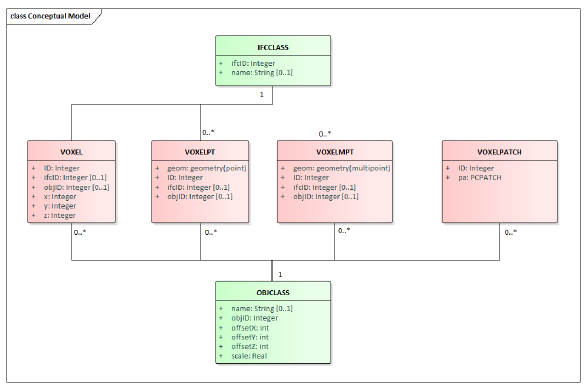
Figure 6. UML diagram for our conceptual